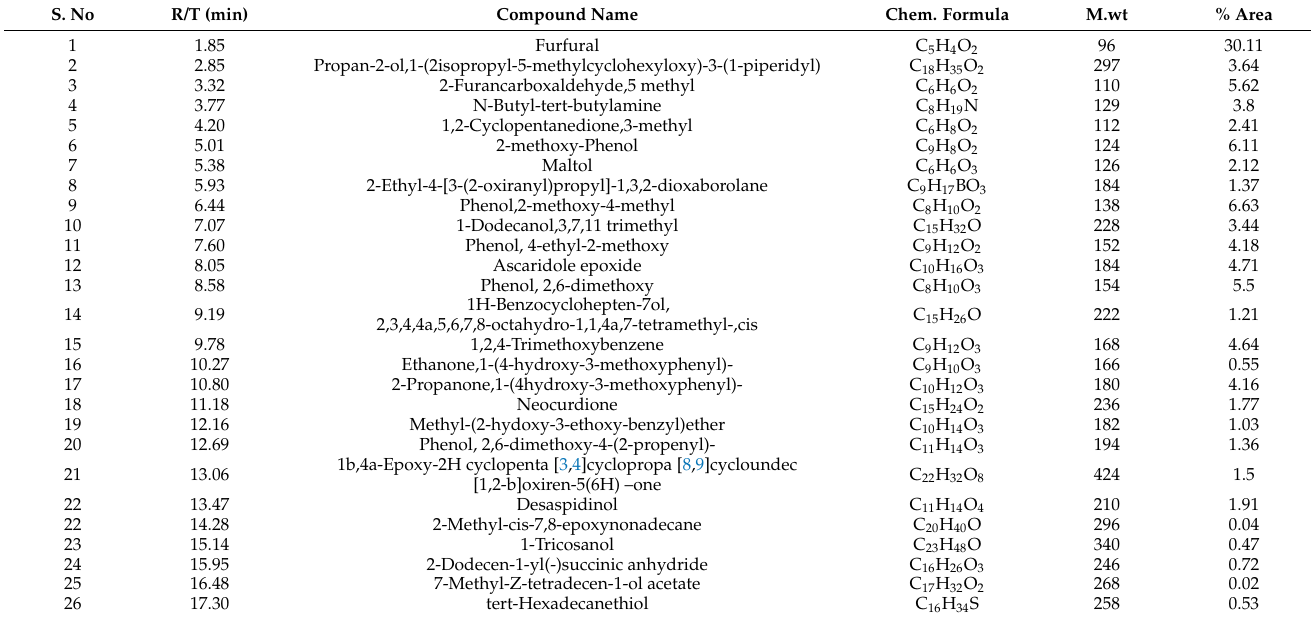
Table 2. Components identified in bio-oil produced from catalytic pyrolysis of pomegranate